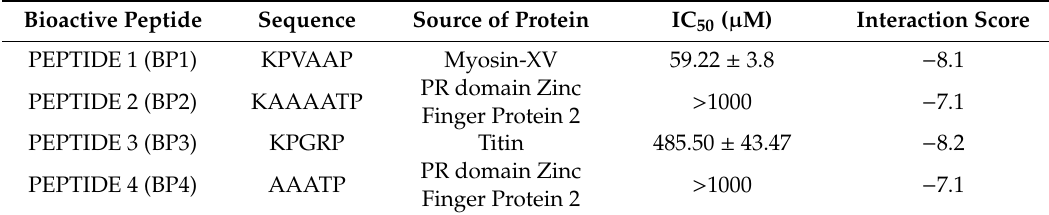
Table 1. Angiotensin I-converting enzyme (ACE) inhibitory peptides derived from dry-cured pork ham: sequence, estimated IC 50 value and interaction score. Captopril (10 µ M) inhibition was used to represent 100% inhibition of ACE activity under the assay